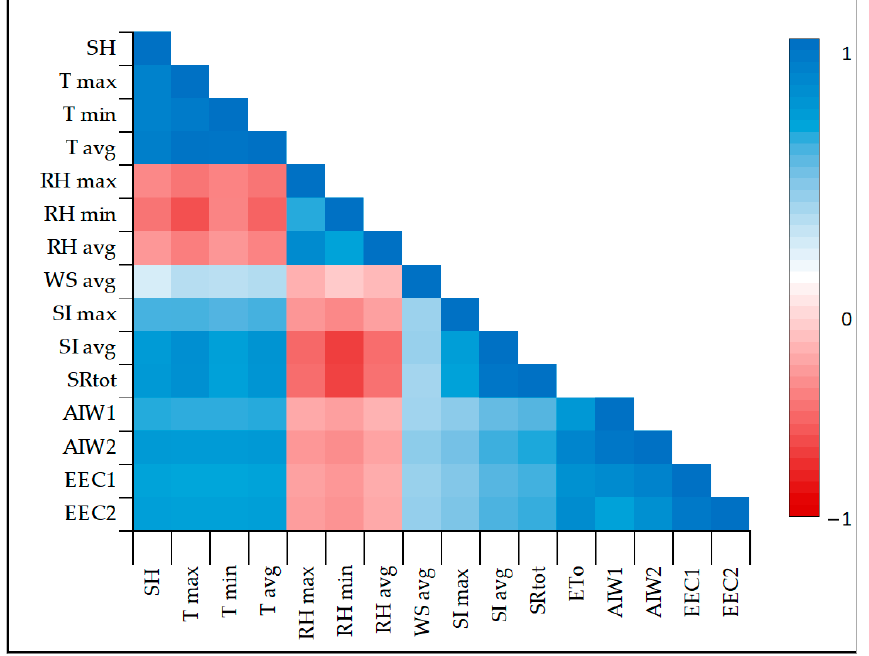
Figure 9. The correlation among the meteorological variables, irrigation water applied, and electrical energy consumption. SR, T max, T min, T avg, RH max, RH min, RH avg, WS avg, SI max, SI avg, SR, AIW1 and AIW2, and EEC1 and EEC2 refer to sun hour, the maximum temperature, minimum temperature, average temperature, maximum RH, minimum RH, average RH, average wind speed, maximum solar irradiance, average solar irradiance, solar radiation, reference evapotranspiration, crop evapotranspiration, applied irrigation water at optimum water use e ffi ciency and optimum palm yield, and electrical energy consumption at optimum water use e ffi ciency and optimum palm yield, respectively.